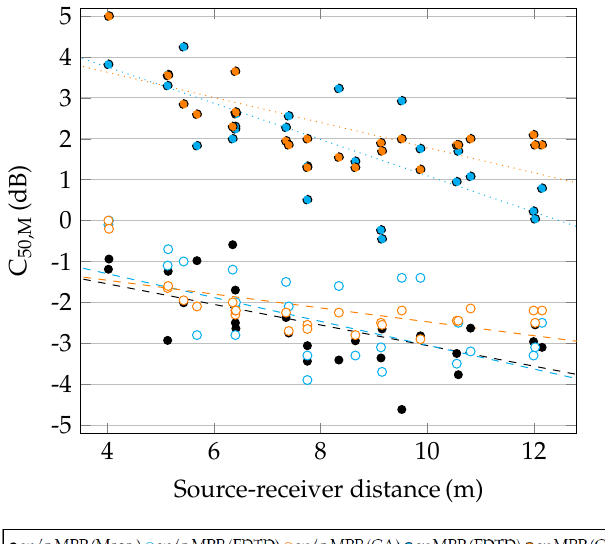
Figure 18. Trend of sound clarity (C 50 ) as a function of the sound source-receiver distance (values and linear regressions). “M” indicates that the values have been averaged over 500 and 1000 Hz. Results of the measurements (“Meas”), the equivalent values derived from the calibrated FDTD model (“w/o MPP”) and the variations due to the introduction of MPPs (“w MPP”) are provided by using both FDTD and GA